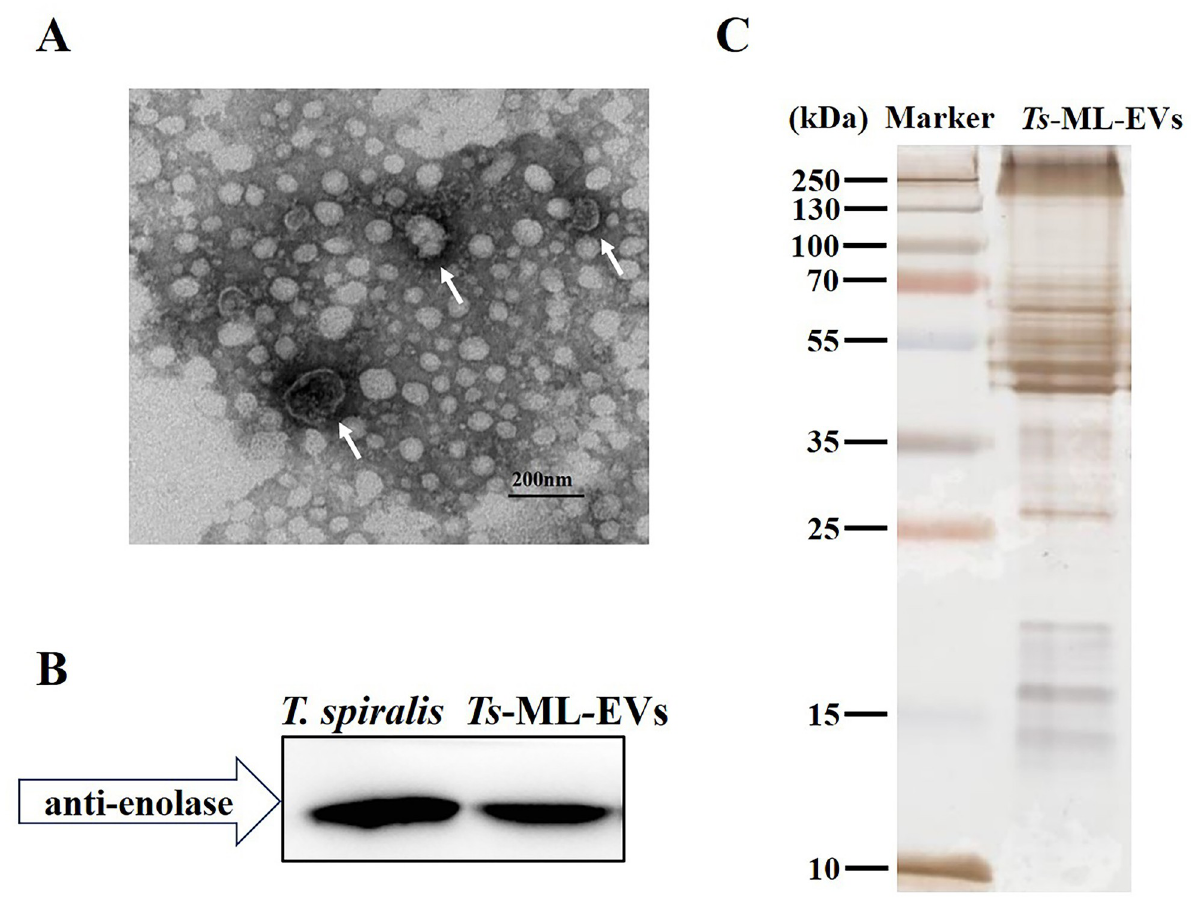
Fig 1. Characterization and protein analysis of Ts -ML-EVs. (A) Morphological characterization of Ts -ML-EVs by TEM. Arrows indicate isolated Ts -ML-EVs. (B) Western blot analysis showing the marker protein of Ts -ML-EVs. (C) SDS-PAGE analyses of purified Ts -ML-EVs using silver- staining.